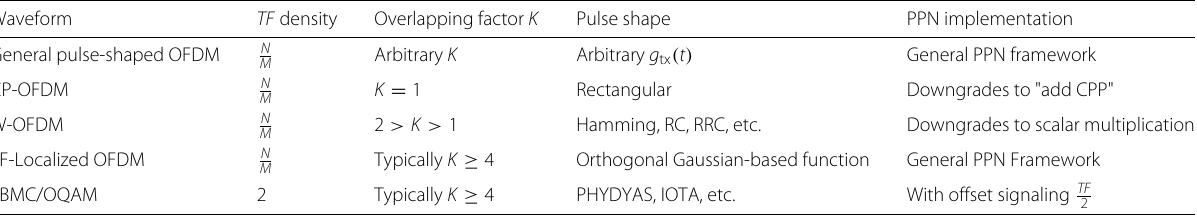
Table 6 Summary of SoTA waveform complexity by PPN implementation framework Waveform TF density Overlapping factor K Pulse shape PPN implementation General pulse-shaped OFDM General PPN framework